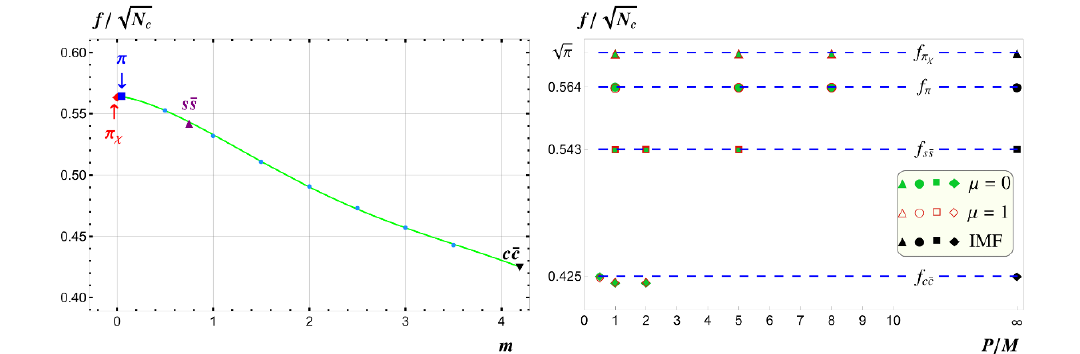
Figure 12 . Meson decay constants as functions of the quark mass (left) and the meson momentum (right). In the right panel, the colored solid/empty symbols signify the decay constants extracted via (3.10) from (cid:22) = 0 ; 1 Lorentz indices, respectively, while the black solid symbols represent the IMF values inferred from